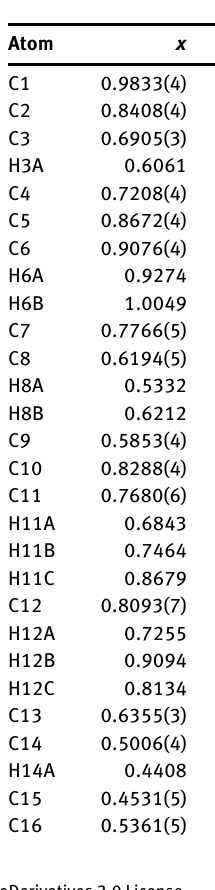
Table 2: Fractional atomic coordinates and isotropic or equivalent isotropic displacement parameters (Å 2